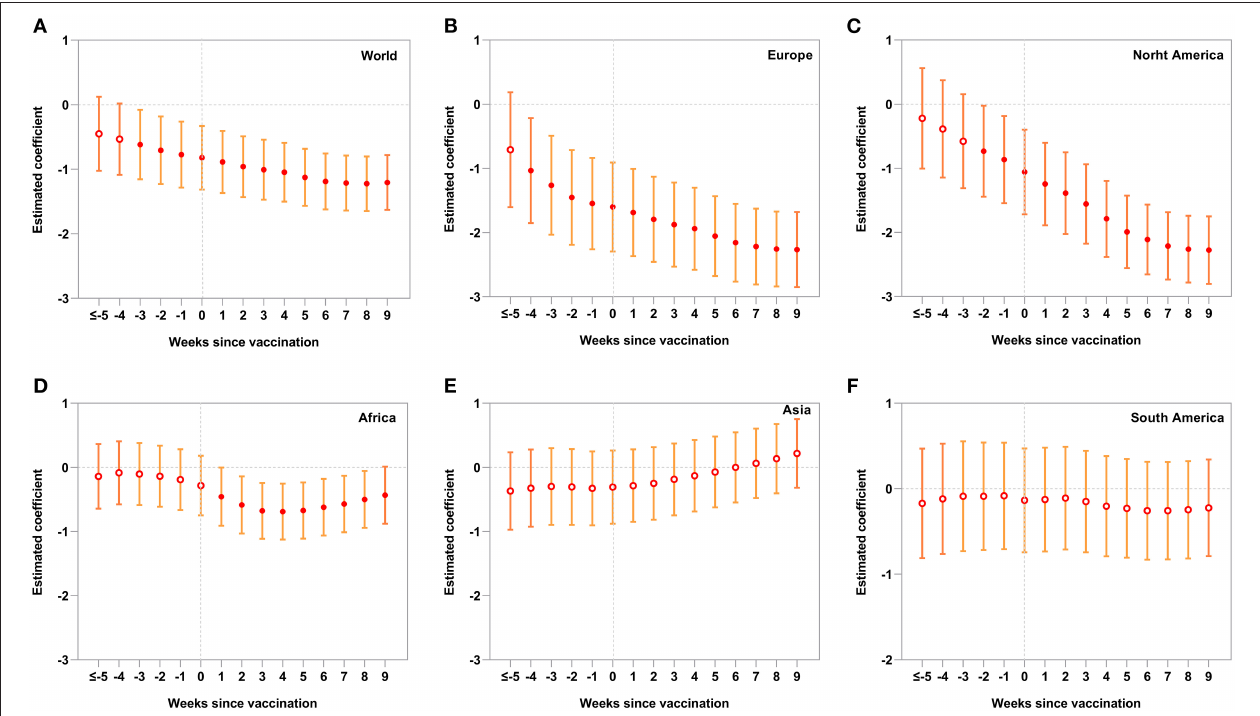
FIGURE 4 | Event-study results on short-term effects of vaccination on COVID-19 cases. We fit the model by ranging k from − 5 to 9 as the start of the intervention in Equation (4). Each column (A–F) represents a separate interrupted time series (ITS) model. The estimated coefficients are plotted along with their 95% confidence intervals (CIs). Vertical dotted lines indicate the week since vaccinations. Red circles are filled if the values are significant ( p < 0.05), and open otherwise. Figures show that VEs gradually improved (a smaller estimated coefficient) and stabilized (a narrower confidence interval) in the World, Europe, and North America over time. In Africa, VEs were gradually increased and changed from non-significance to significance since the vaccination.